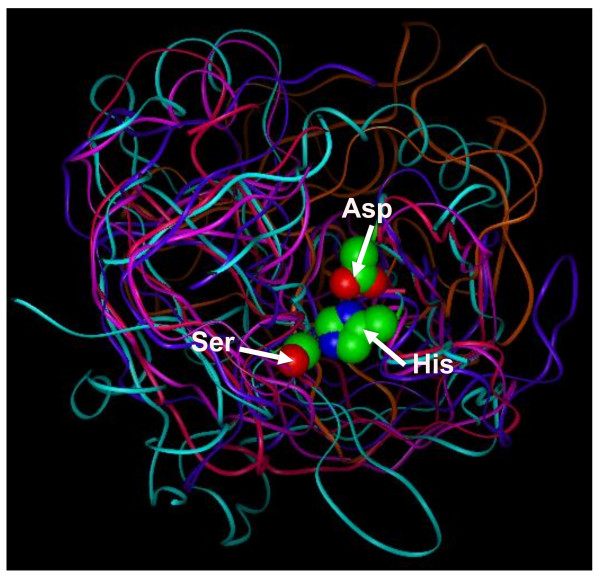
Superposed structures of X-ray and modeled structures of the selected proteases of the PA clan. Structures of the protozoan (Plasmodium falciparum, magenta), archaeon (Pyrococcus furiosus, cyan), fungus (Neurospora crassa, purple) and plant (Arabidopsis thaliana, fuchsia pink) PA proteases were superposed with the human x-ray structure (1SGI, Homo sapiens, orange). The catalytic triad residues (His, Asp, Ser) are shown in ball and stick models.